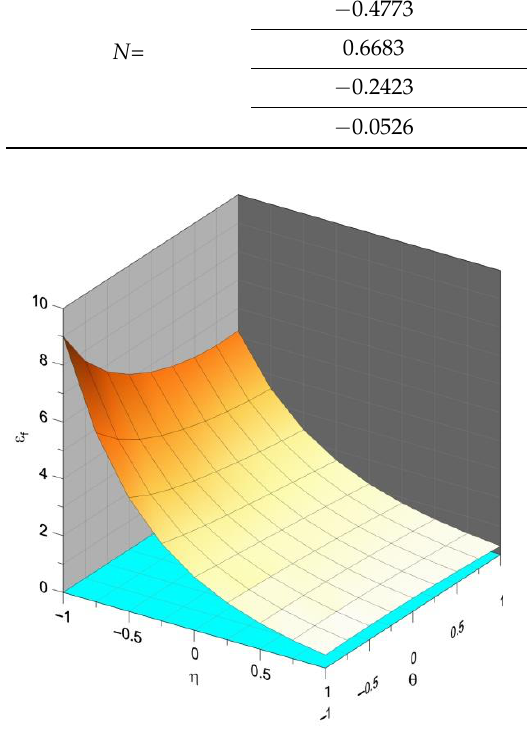
Figure 5. Simplified fracture locus.